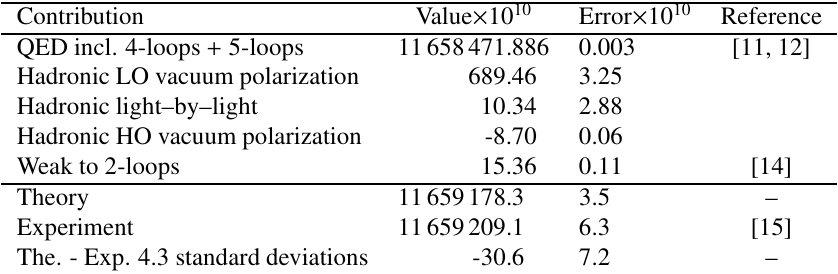
Table 1. Standard model theory and experiment